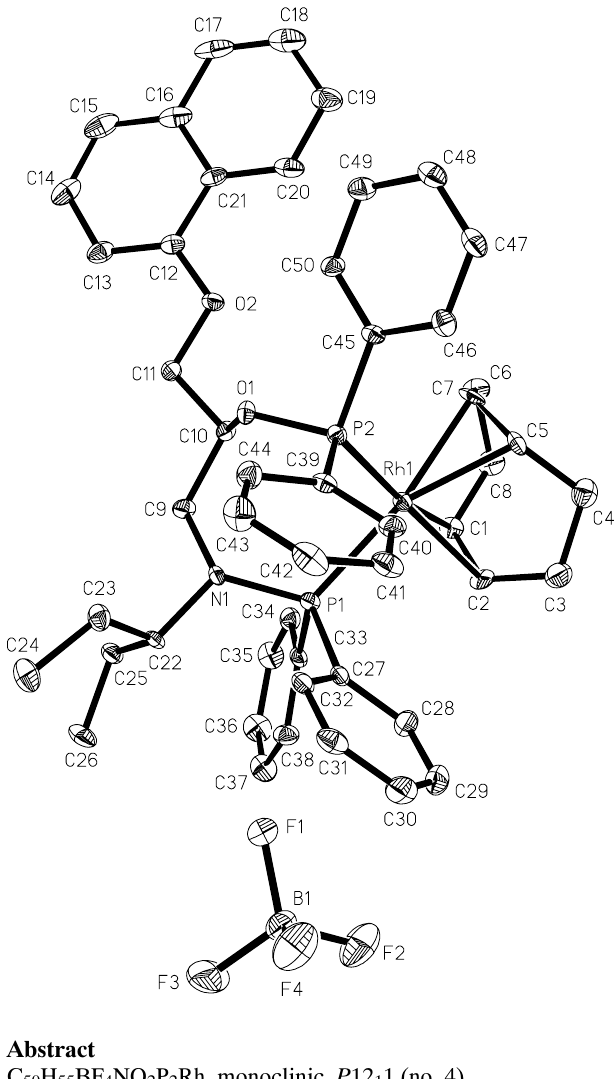
Source of material